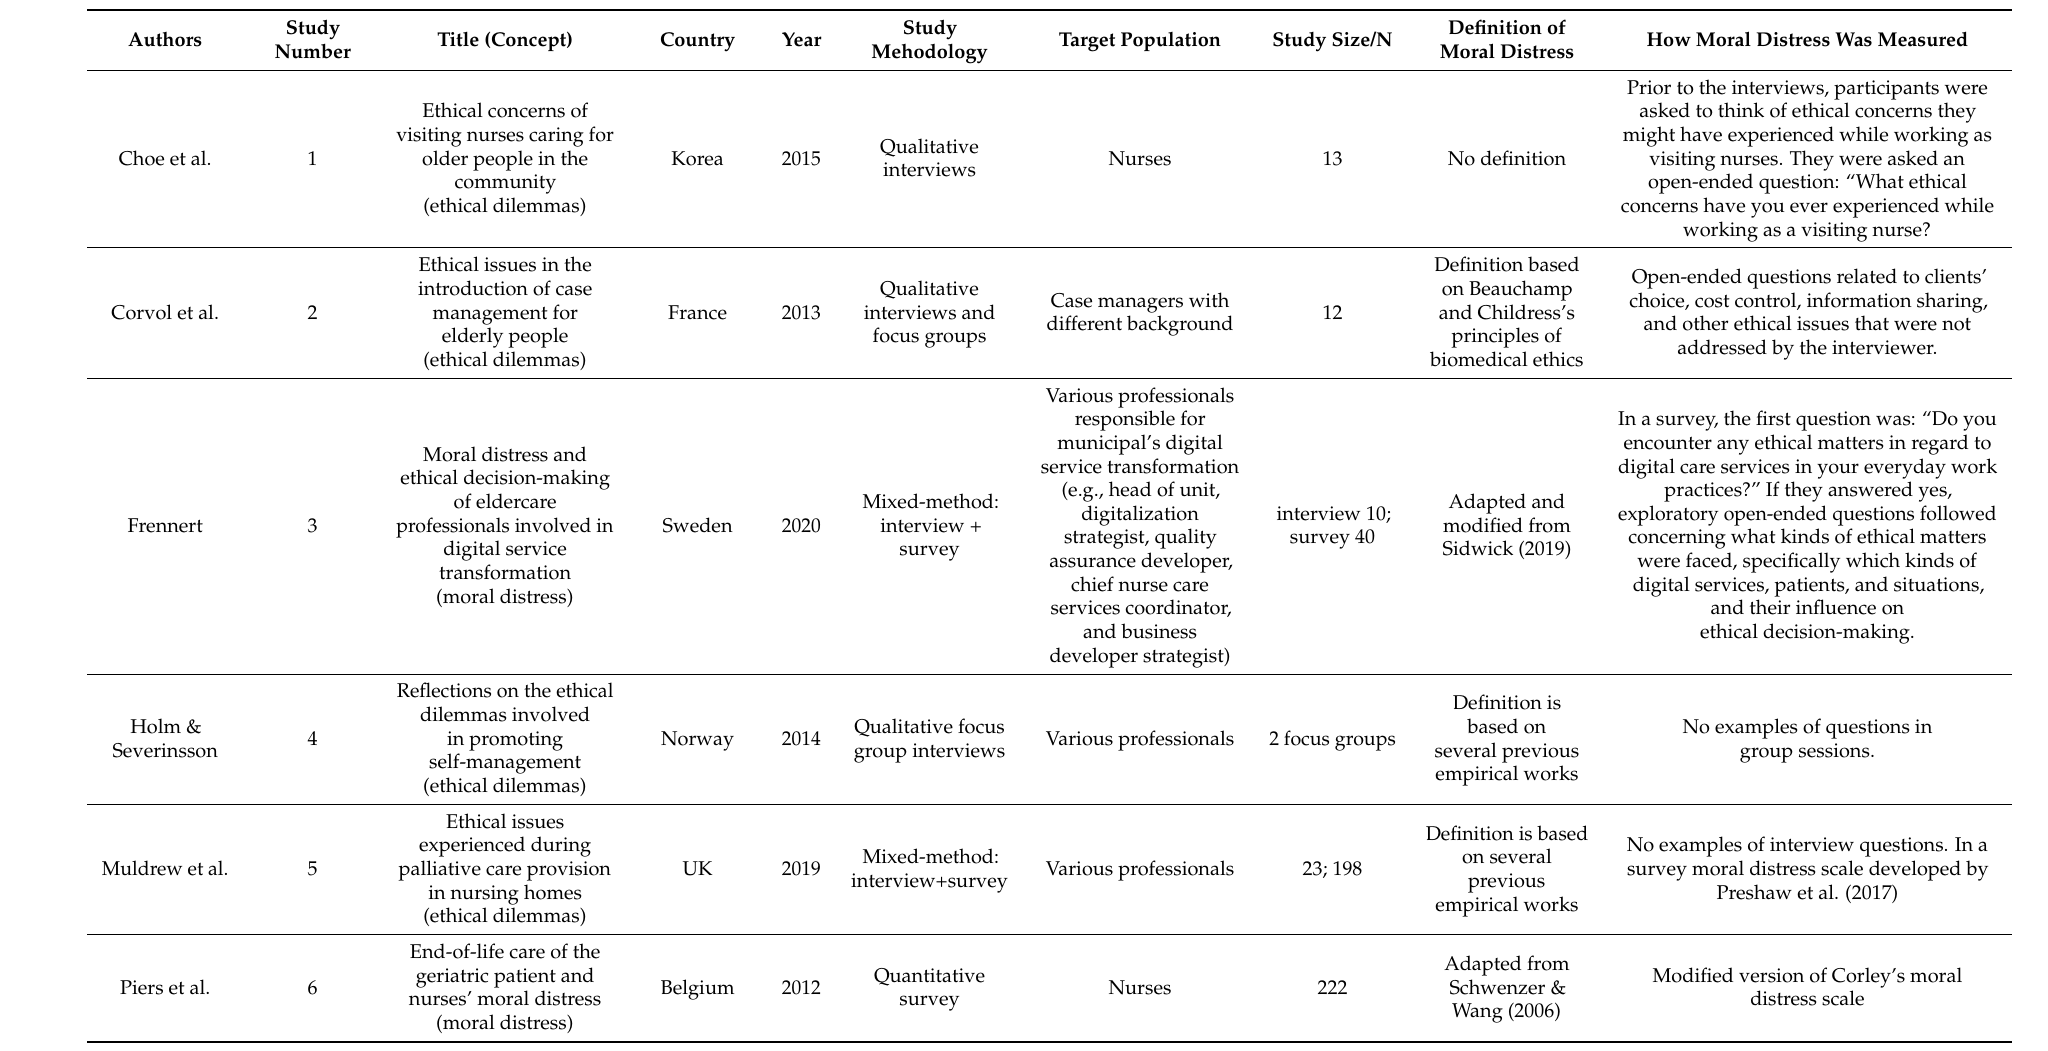
Table 1. Characteristics of the included studies (N = 14) evaluating the causes and consequences of moral distress in